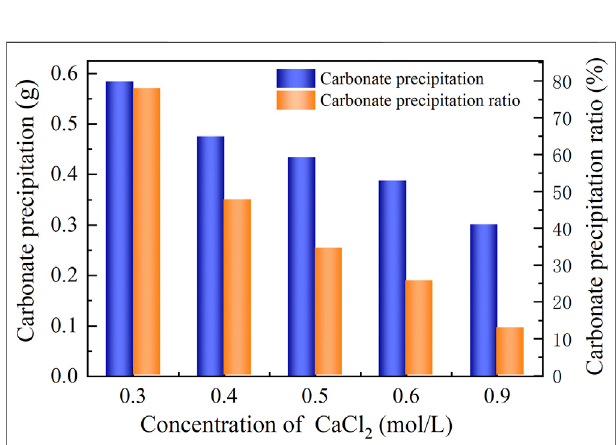
FIGURE 9 | Relations of the actual mass of carbonate precipitation and the precipitation ratio (PR) versus the CaCl 2 concentration in the modi fi ed EICP